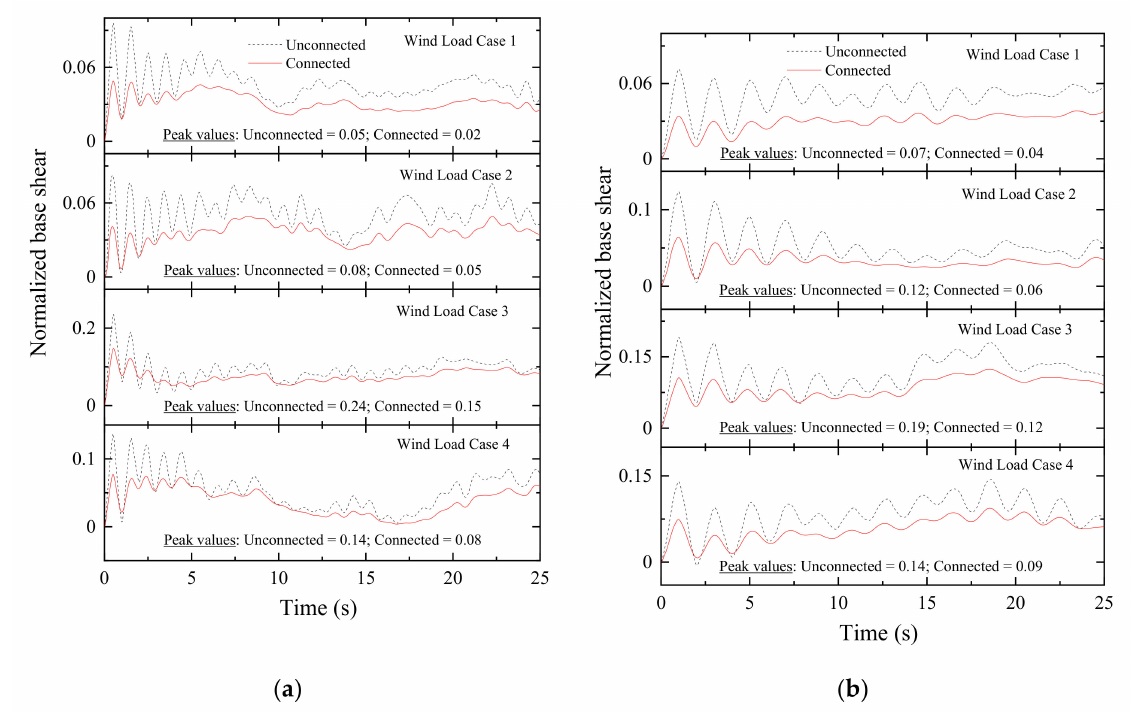
Figure 28. Time history of normalized base shear under wind excitation in: ( a ) a coupled stiff building and ( b ) a coupled flexible building when semi-active MR dampers are used as coupling devices in Configuration